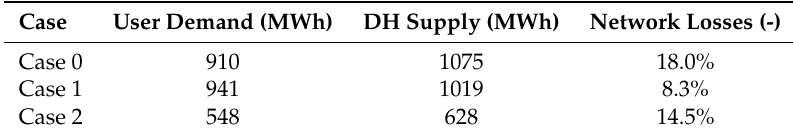
Table 1. Annual energy performance of the different